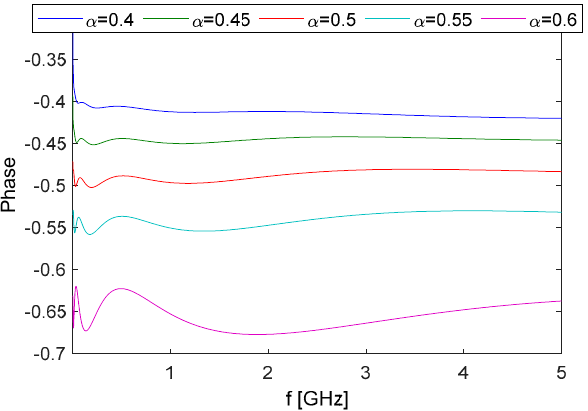
Figure 7. Phase of the rational approximation function G ( ω ) for different values of α . Again, the amplitude plot represents the fractional impedance in a wider bandwidth than the phase plot.